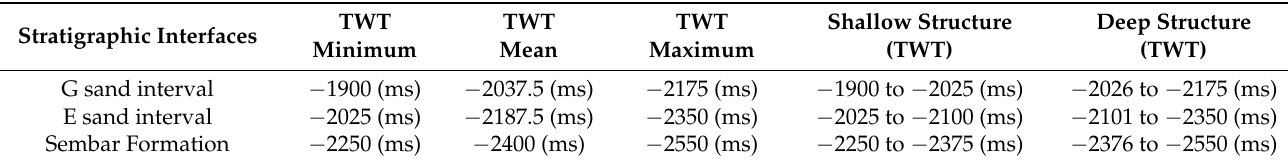
Table 2. Minimum, mean, and maximum TWT variations of the stratigraphic interfaces in the study